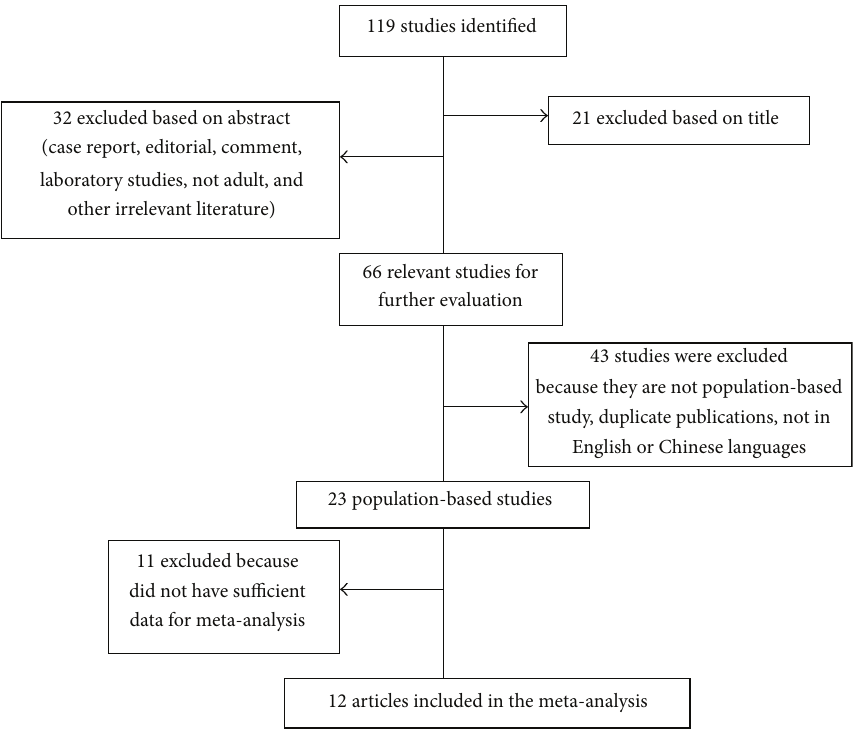
Figure 1: Flow chart demonstrating how the identified published studies were included in the